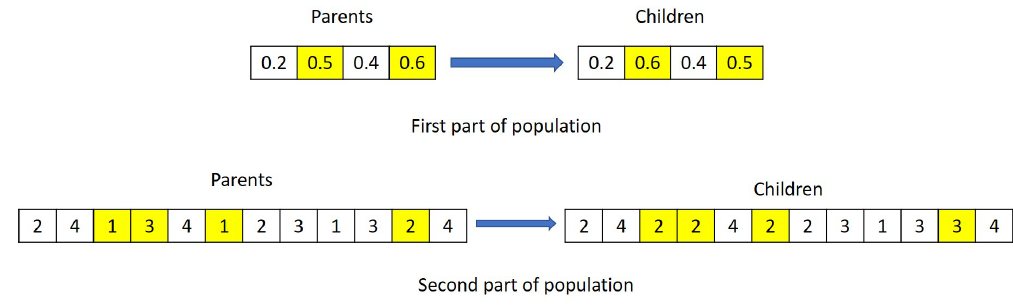
Figure 9. An example of mutation